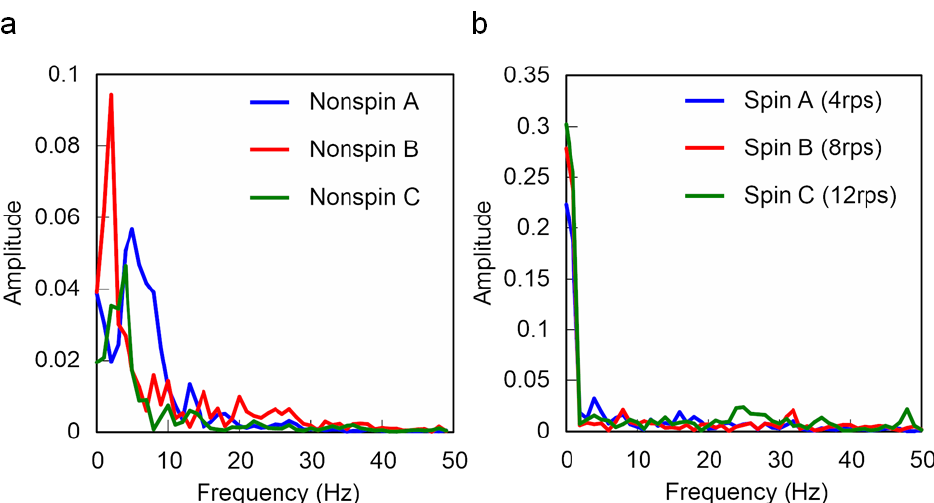
Figure 11. Amplitude of Cs obtained from fast Fourier transform (FFT) analysis in the cases involving ( a ) nonspinning and ( b ) spinning balls.